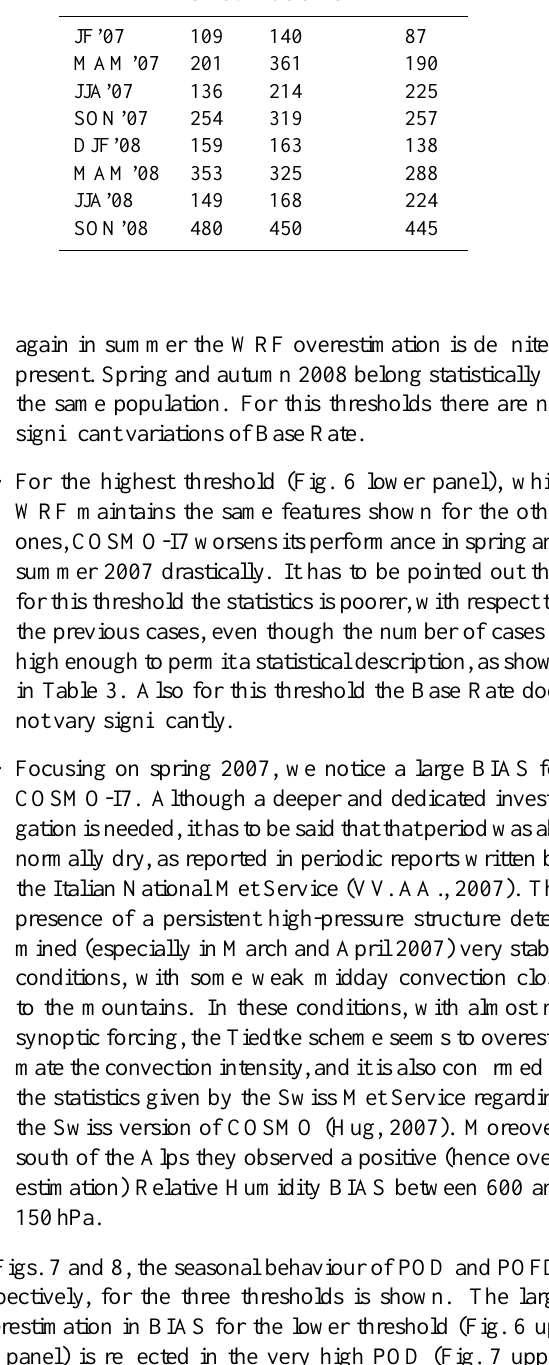
Table 3. Number of cases with a 20mm24h − 1 threshold in each three-months period (first column): observations (second column), COSMO-I7 forecast (third column) and WRF forecast (fourth col- umn).